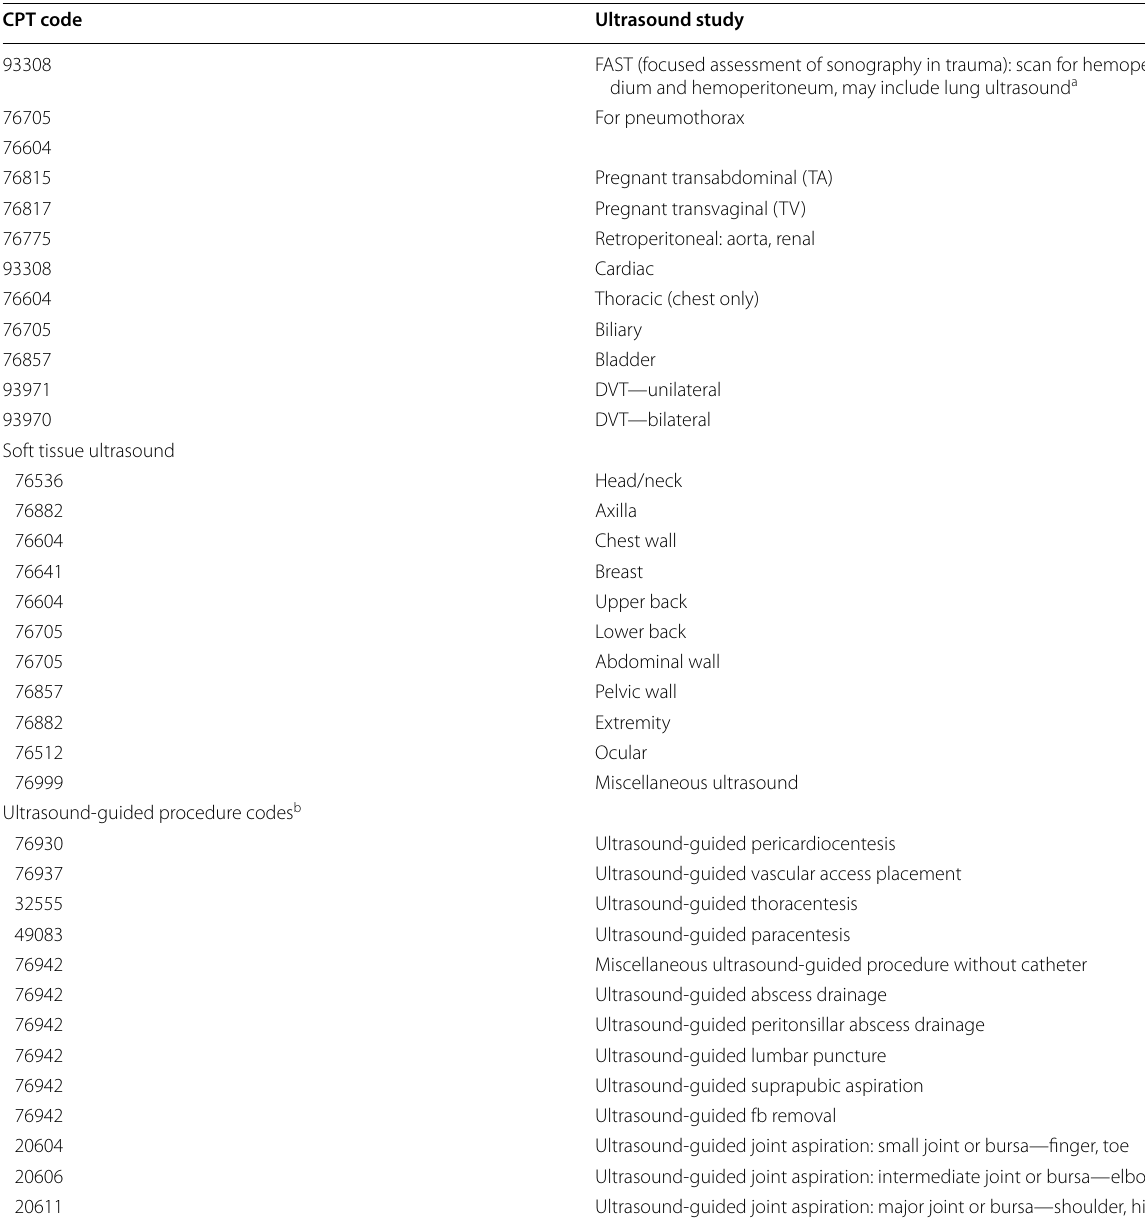
Table 1 Common current procedural terminology (CPT) codes associated with point-of-care